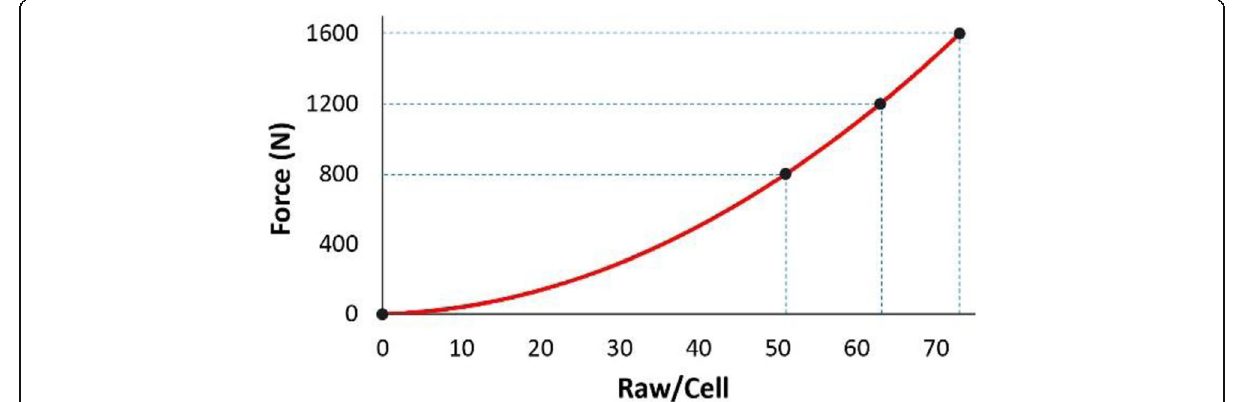
Fig. 9 Calibration curve generated by the I-Scan software